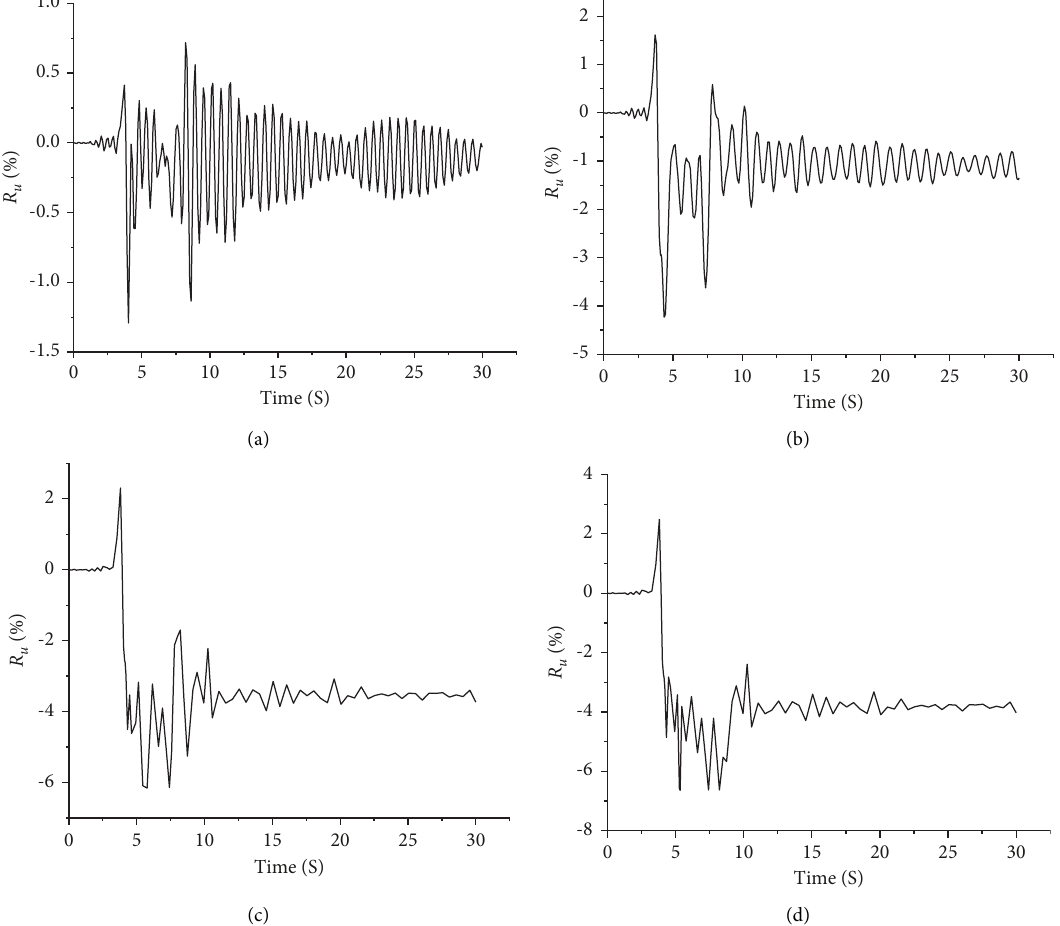
Figure 24: Time-history curve of pier top displacement angle. (a) Condition 1. Dynamic stability. (b) Condition 2. Dynamic stability. (c) Condition 3. Dynamic instability. (d) Condition 4. Dynamic